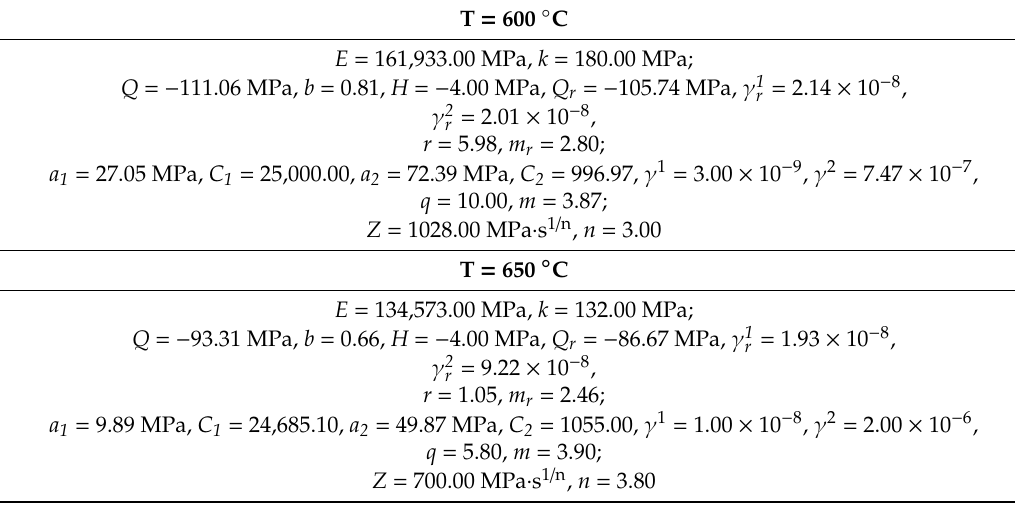
Table 4. Material parameters for the modified model at 600 and 650 ◦